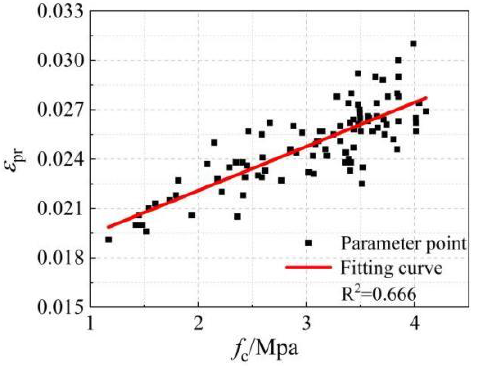
Figure 15. Fitting curve of compressive strength and peak compressive strain.